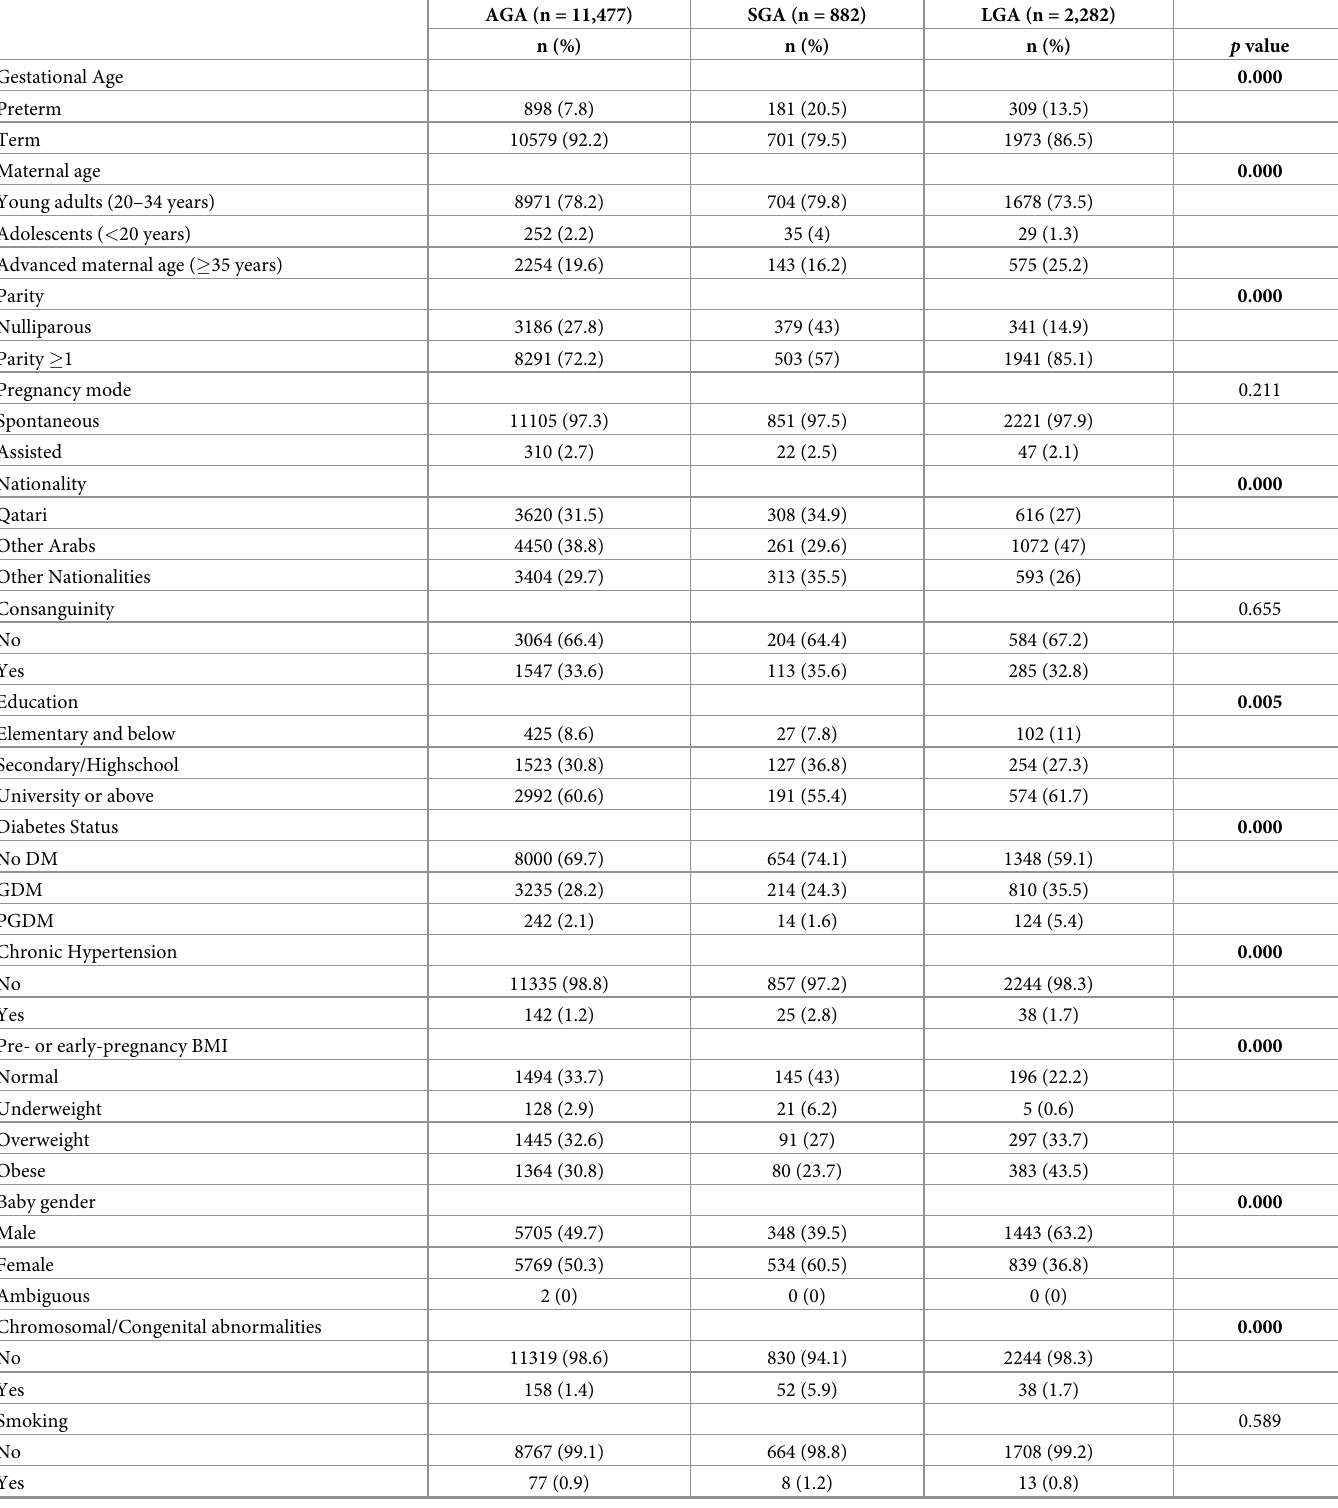
Table 1. Characteristics of the study